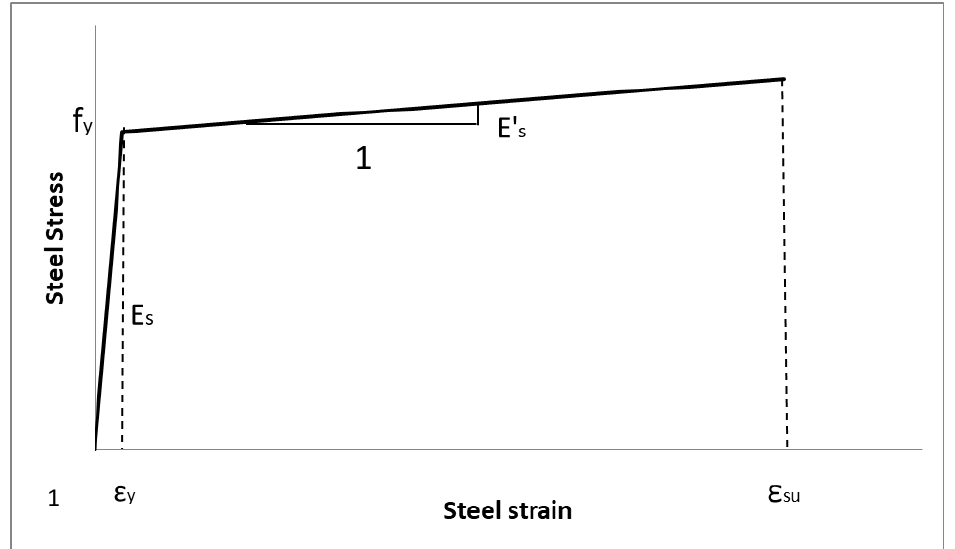
Figure 2. Steel bilinear stress–strain curve.